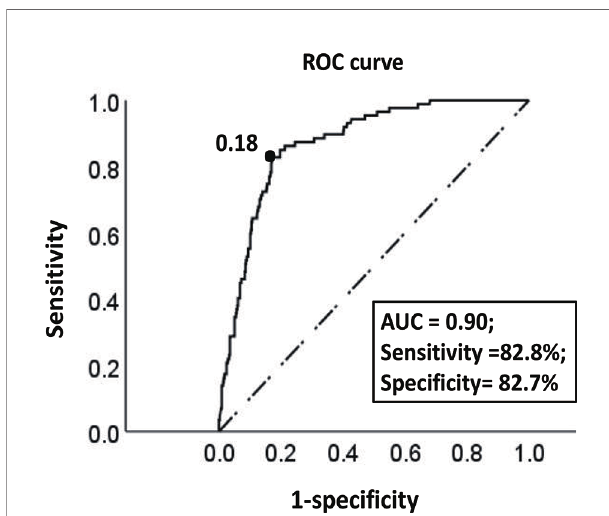
FIGURE 4 | The ROC curve of the optimal threshold value of the probability of LNM predicted by the model. The area under the curve at the “ black dot ” is the largest, which suggests that the optimal threshold value of the probability of LNM predicted by the model is 0.18 (area under the curve = 0.90; sensitivity, 82.8%; speci fi city, 82.7%) (dotted line: reference line; solid line: the ROC curve of the